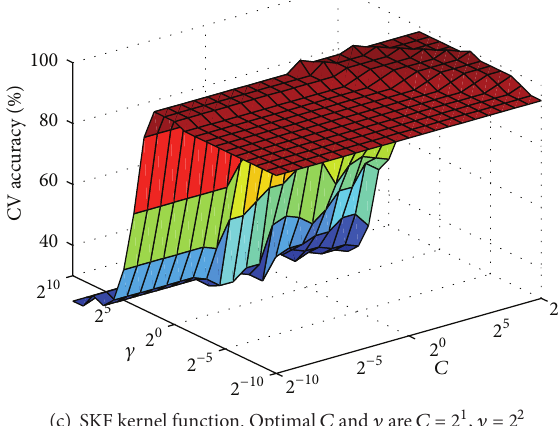
(a) Polynomial kernel function ( 𝑑 = 3 ). Optimal 𝐶 and 𝛾 are C = 2 −10 , 𝛾 = 2 8